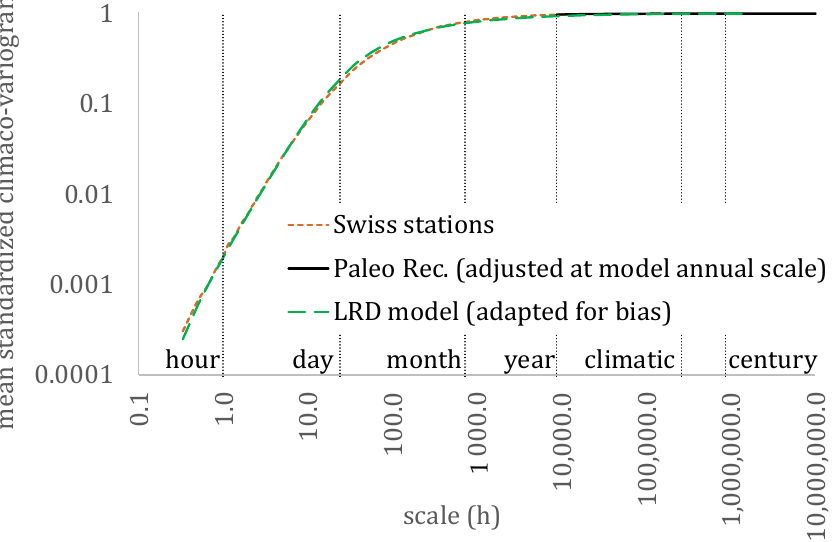
Figure 6. The mean standardized climaco-variogram for the analysis by Dimitriadis et al. [6] (daily and hourly resolution), for the Swiss dataset (10 min resolution) and for the paleoclimatic reconstructions (annual resolution).